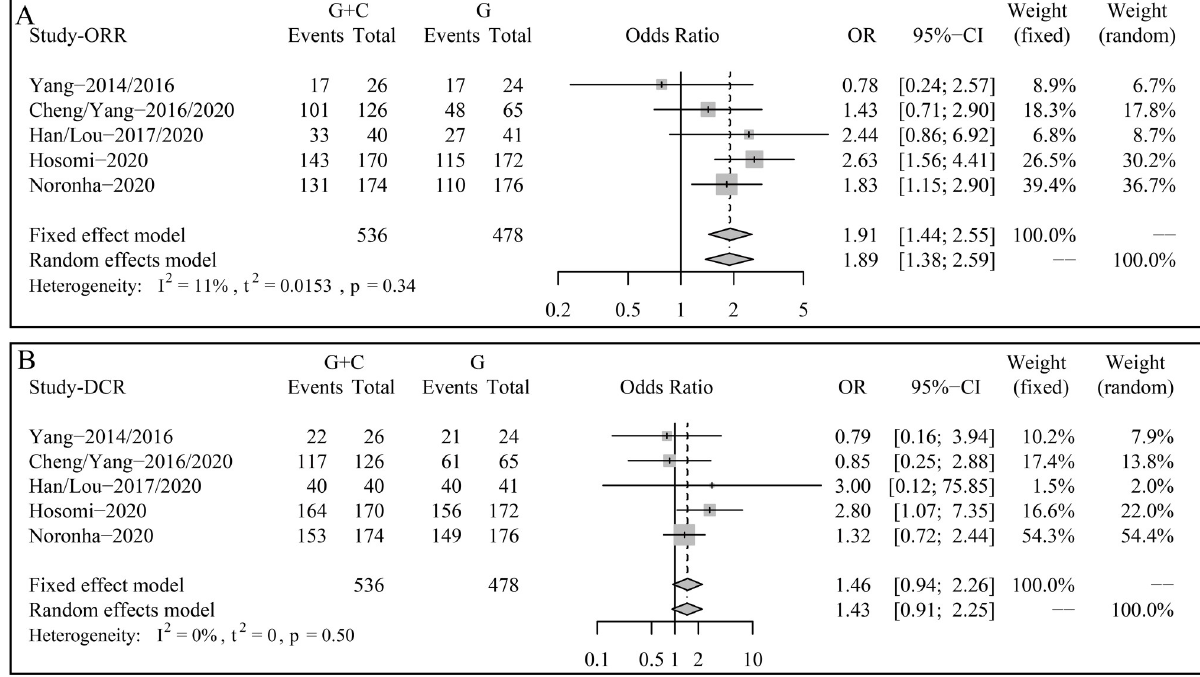
Fig 4. Forest plots of (A) objective response rate (ORR) and (B) disease control rate (DCR) for odds ratios (ORs).